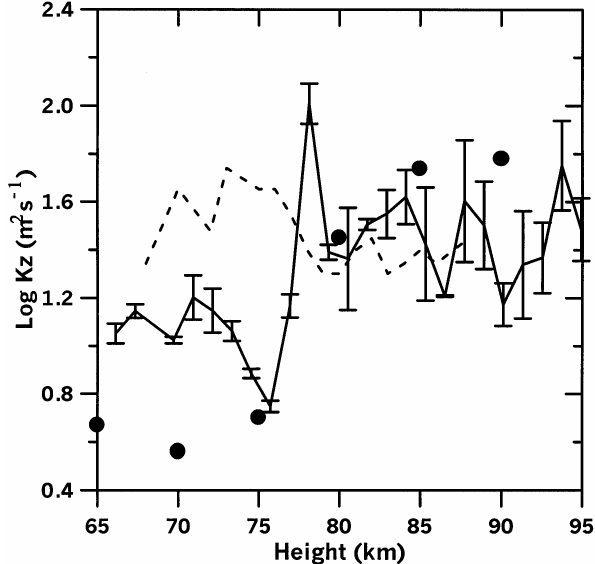
Fig. 6. A comparison of the eddy diffusion coefficients (K z ) in the mesosphere over Gadanki with those obtained by others. Solid line represents K z over Gadanki for the month of December. Dashed line and solid circles represent winter values of K z obtained by R¨ottger (1986) over Arecibo (18.3 ◦ N, 66 ◦ W) and Lubken et al. (1993) over high latitudes, respectively. Vertical bars show stan- dard errors in K z values over Gadanki in